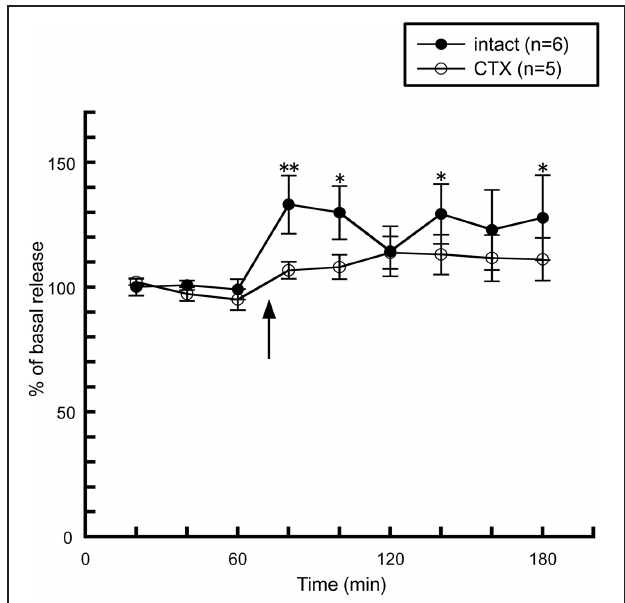
FIGURE 5 | The effect of four taste mixture solutions on the release of histamine in the anterior hypothalamus of intact ( n = 6) and chorda tympani-transected (CTX) rats ( n = 5) [Treesukosol et al. (2003)]. The arrow indicates the time point of taste stimuli. The average mean value in the first three samples preceding taste stimuli was taken as 100%. Values are presented as percentages of the mean basal release ± SEM ∗∗ p < 0 . 01, ∗ p < 0 . 05 compared with the basal release of each group,